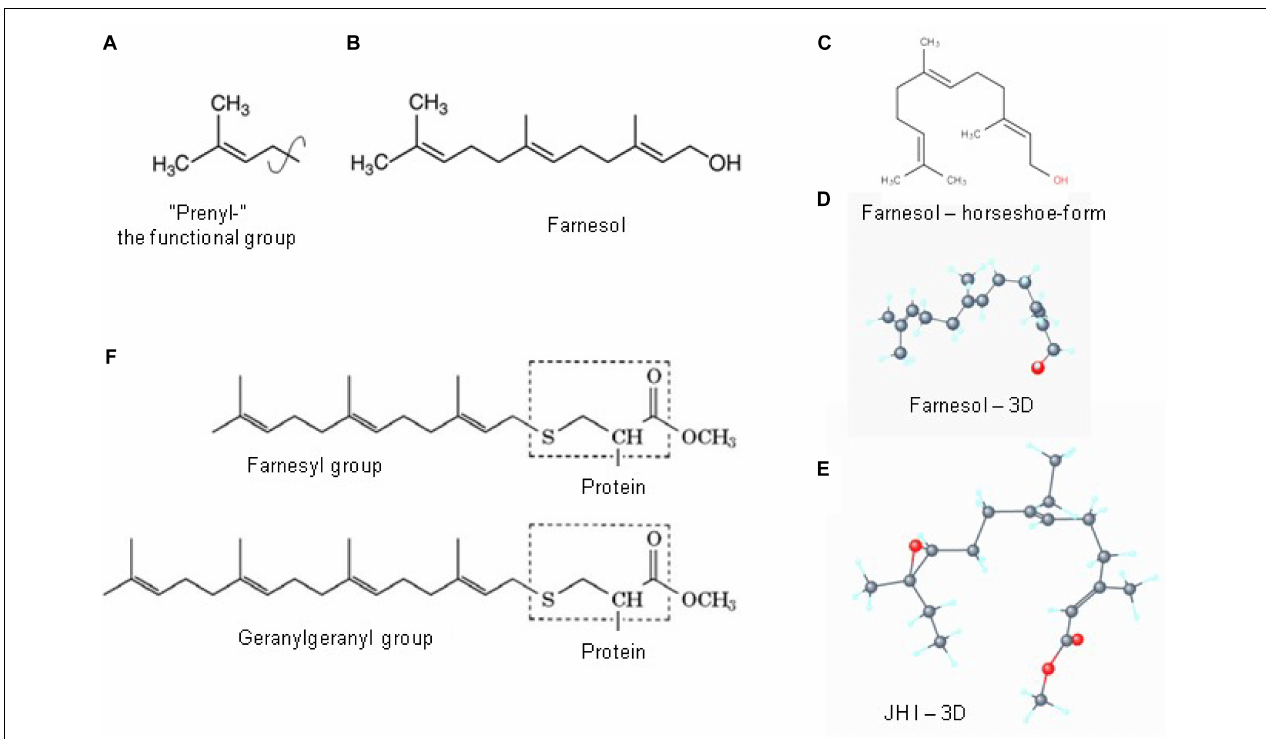
FIGURE 6 | Prenylation. (A) The chemical structure of a “prenyl”-group and of farnesol (B) . In textbooks farnesol is usually depicted in its linear 2D configuration. (C) Its 3D conformation is horseshoe-shaped. (D,E) The 3D configuration showing all atoms of all- trans farnesol and of Juvenile Hormone I (JH I) (according to PubChem). (F) Protein prenylation is the covalent addition of a farnesyl- or geranyl-geranyl moiety to the C terminus of specific proteins, e.g., α or γ G protein. Adapted from Wikipedia